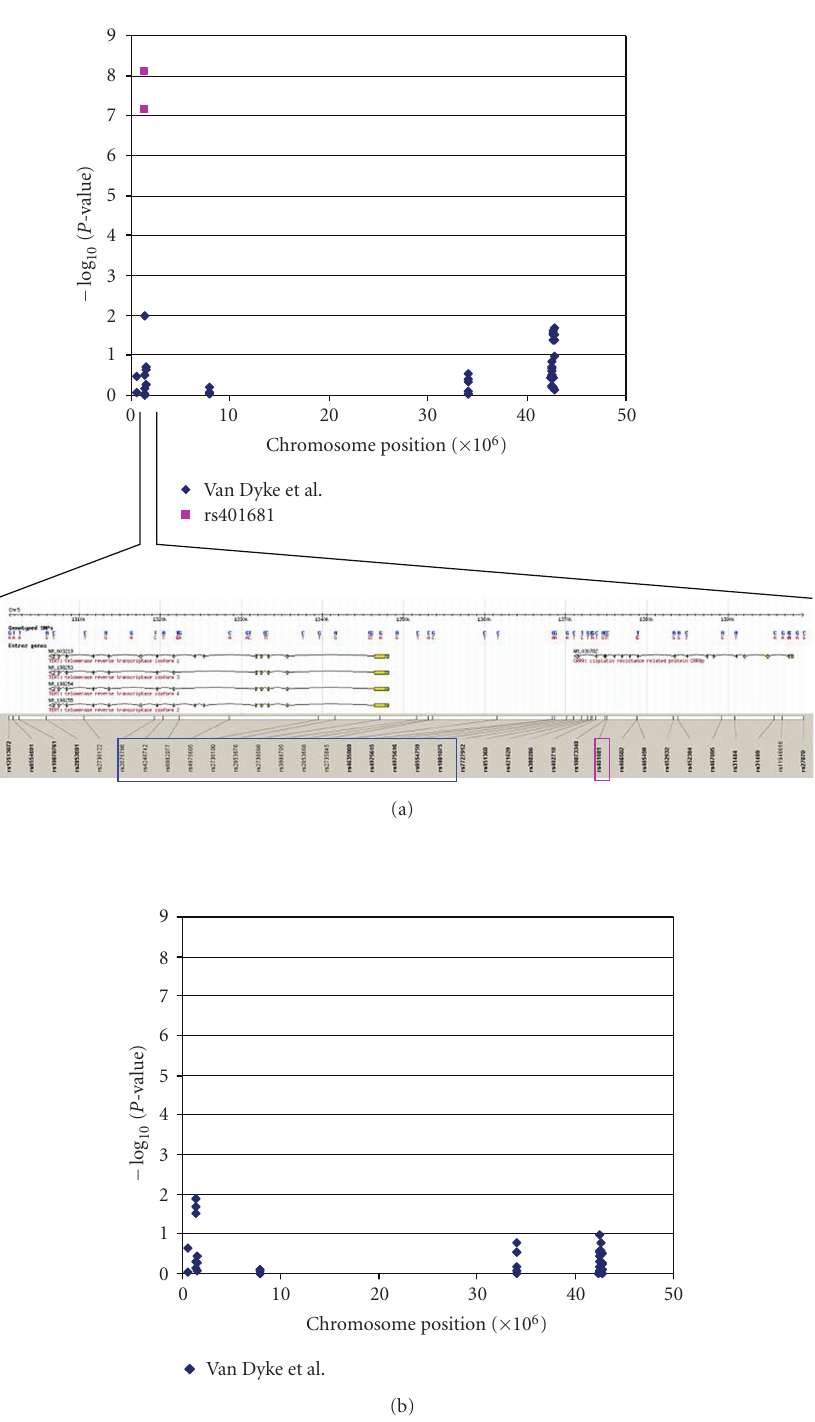
Figure 1: (a) Associations between chromosome 5p SNPs and NSCLC risk among Caucasians by chromosome position. Blue markers signify SNPs examined in our study. Pink markers indicate associations between rs401681 and lung cancer risk identified in the Rafner et al. (2009) and Wang et al. (2008) papers [2, 3]. The region of 5p surrounding rs401681 is expanded in the figure. Pink and blue rectangles surround rs401681 in CLPTM1L (aka CRR9 ) and the region of SNPs included in our study in TERT , respectively. (b) Associations between chromosome 5p SNPs and NSCLC risk among African Americans by chromosome position. Blue markers signify SNPs examined in our